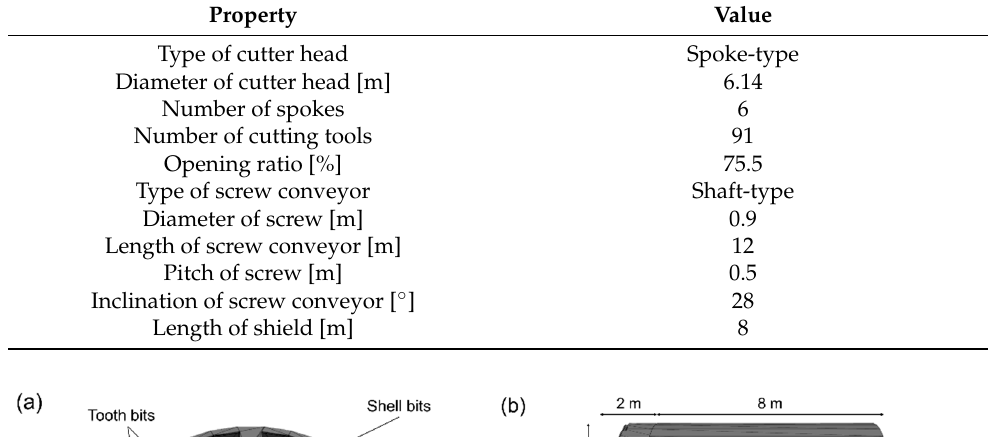
Table 2. Dimensions of EPB shield model for numerical simulation.